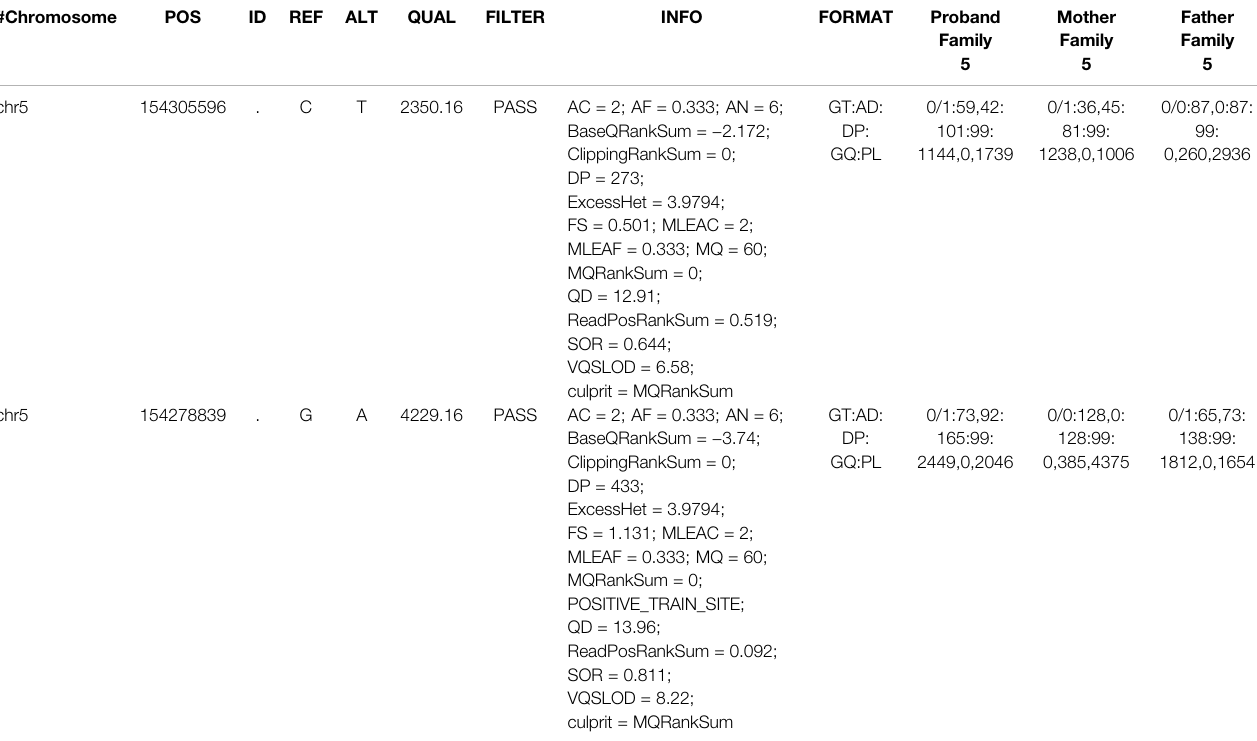
TABLE 2 | Reanalysis of GEMIN5 variant (family 5). #Chromosome